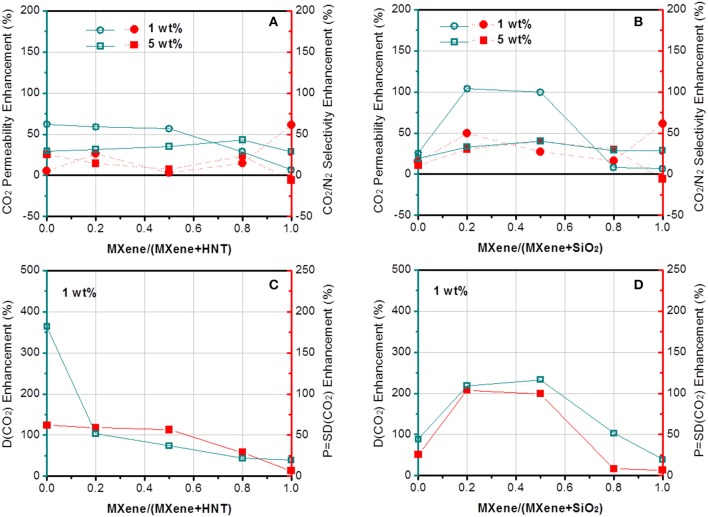
The enhancement of (A,B) CO2 permeability and CO2/N2 selectivity and (C,D) CO2 diffusivity of Pebax-MXene/HNT and Pebax-MXene/SiO2 membranes.